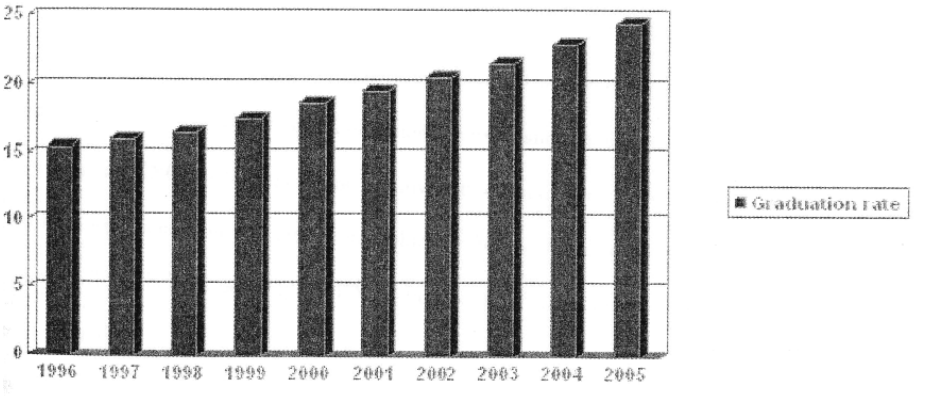
Figure 4. The tendency of average graduation